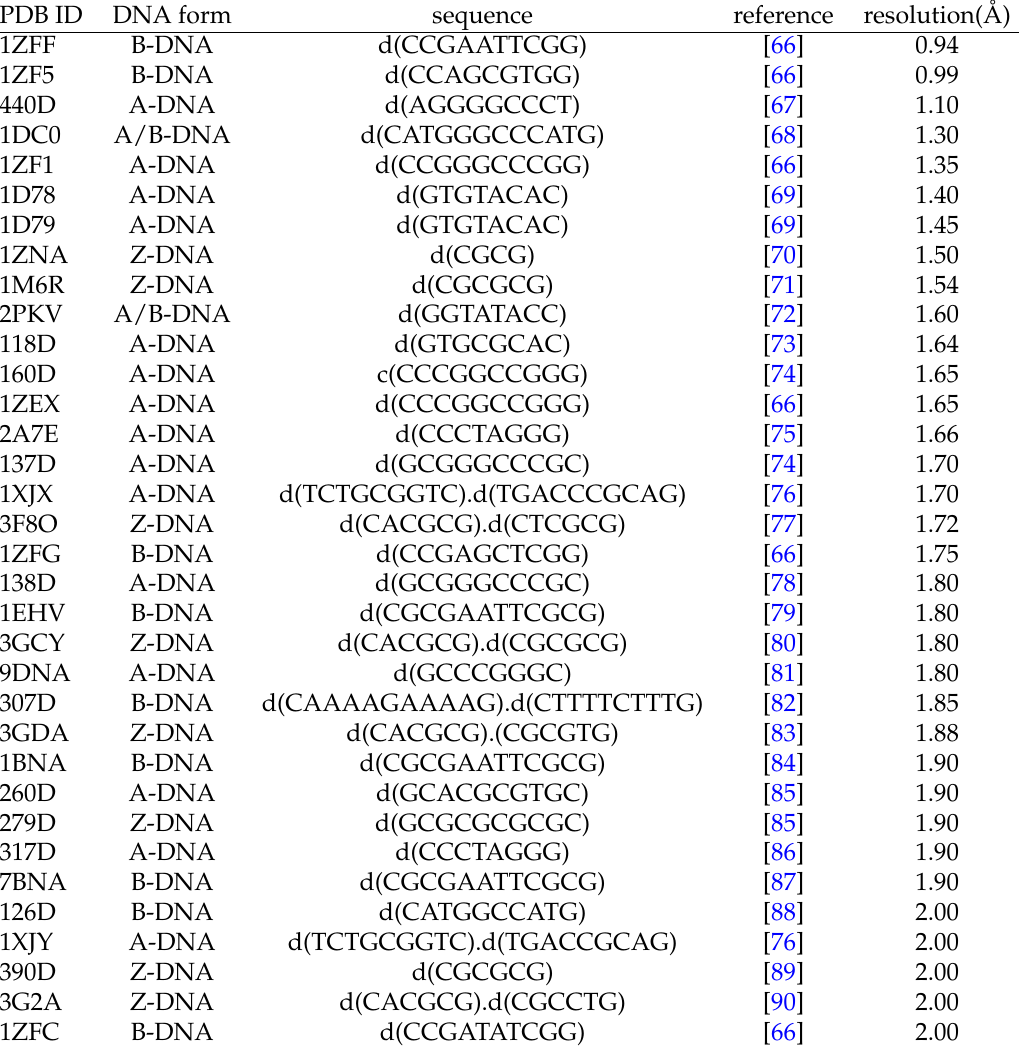
Table 6. Structures examined to determine spacing and